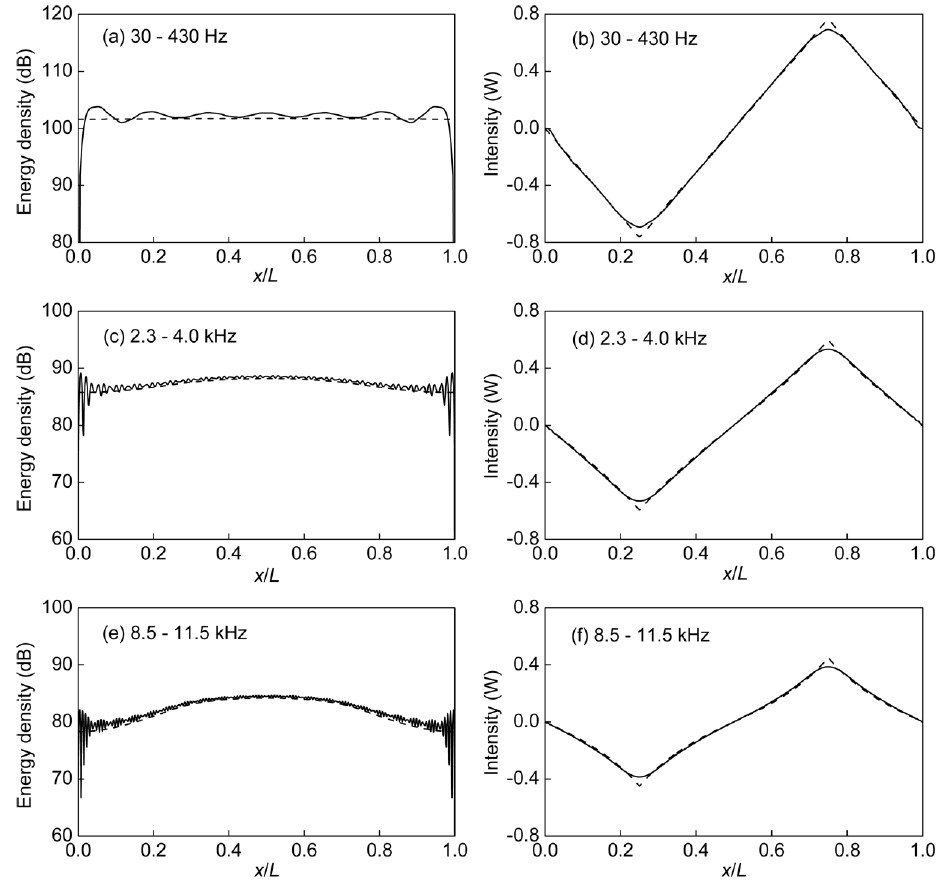
Fig. 4. Response of the beam when distributed force is applied. —, exact solution from modal analysis; - - -, random EFA approximation. (a), (c), (e): energy density distribution in different frequency bands; (b), (d), (f) intensity in different frequency bands. The reference energy is 1 × 10 − 12 J m − 1